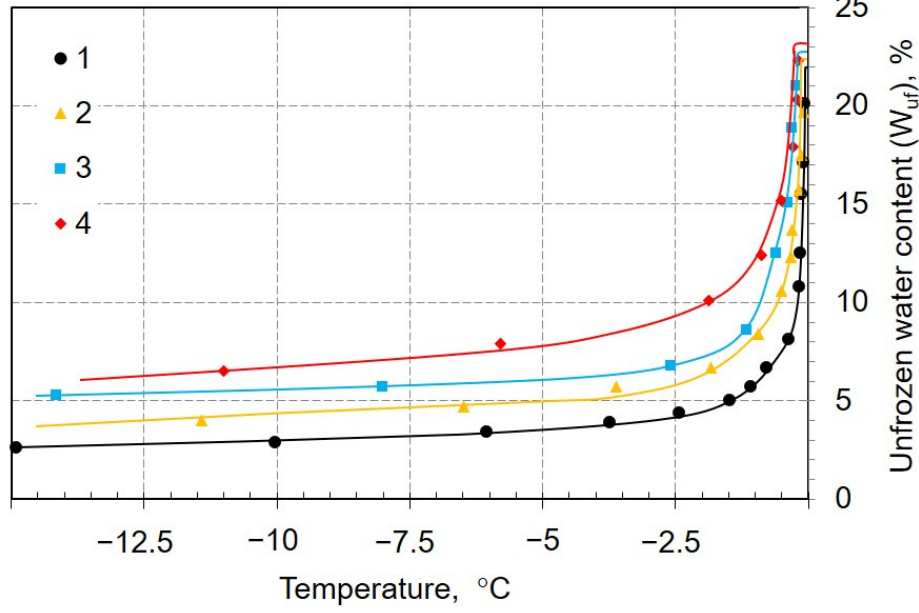
Figure 3. Temperature-dependent unfrozen pore water content in clay samples with peat contents ( I r ) of 0.4% (1); 2.7% (2); 3.1% (3); 6.2% (4).